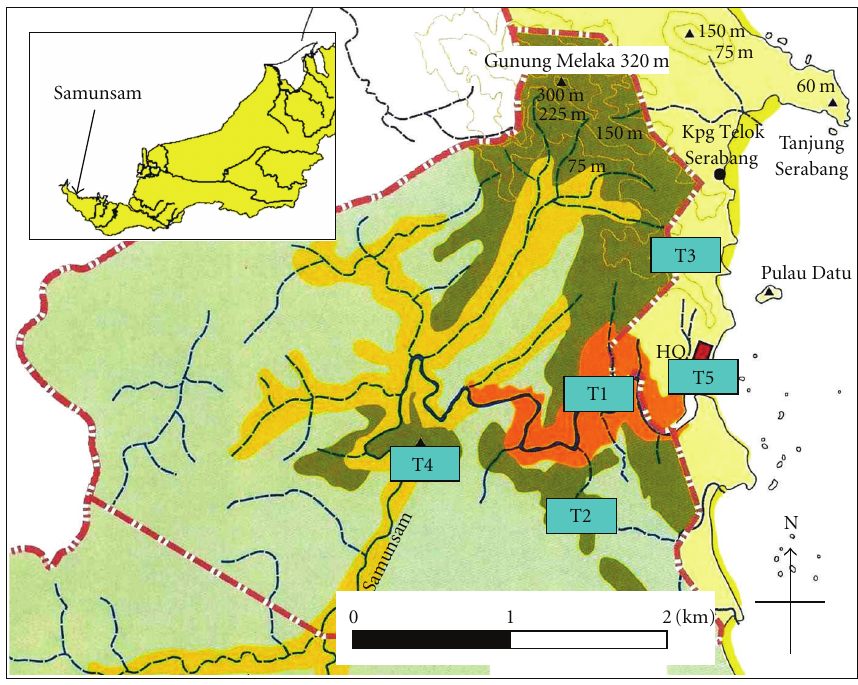
Figure 1: Map of the Samunsam Wildlife Sanctuary to indicate area of line transects